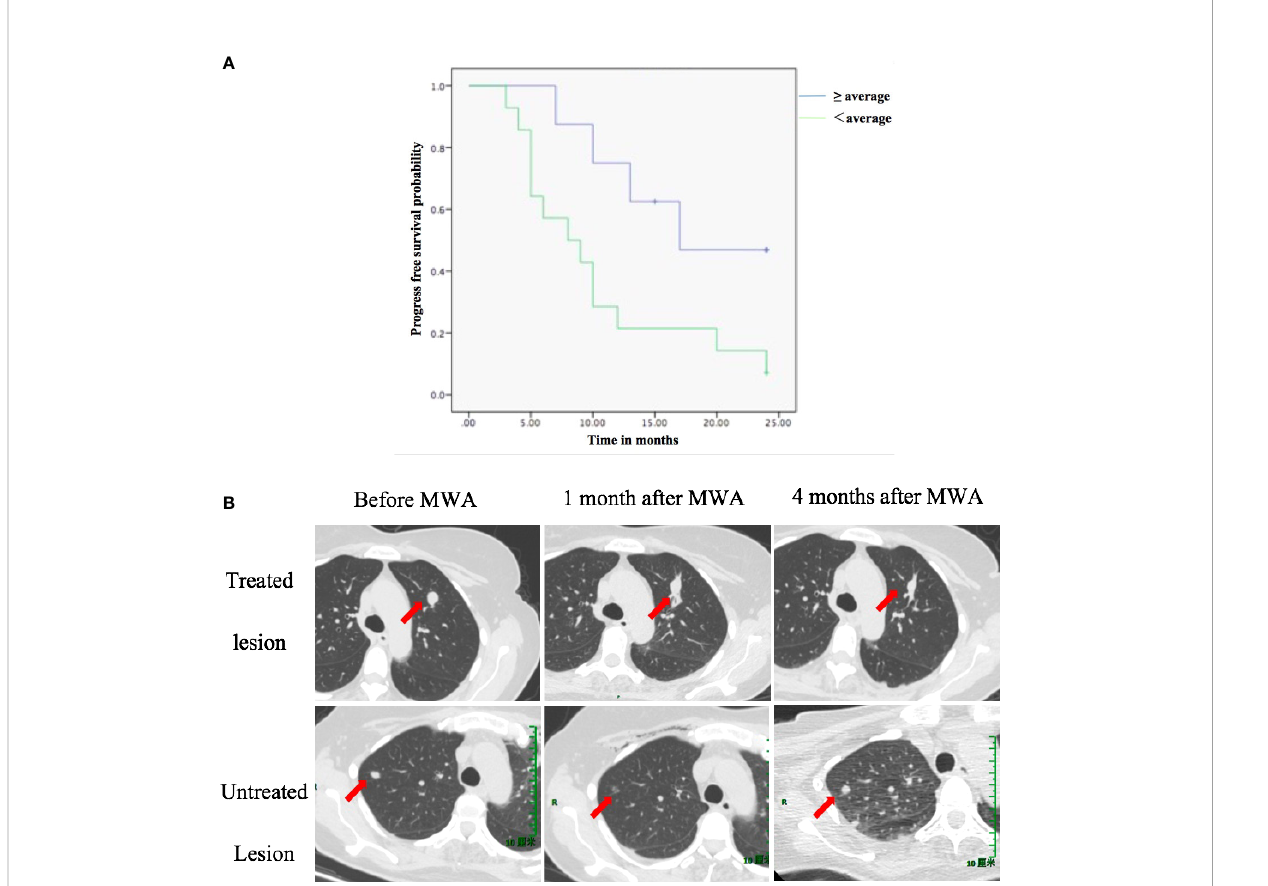
FIGURE 3 The reduction in the proportion of Treg cells is associated with PFS. (A) PFS according to a reduction in the proportion of Treg cells between D0 and M1. (B) A case showing that a reduction in proportion of Treg cells predict PFS. A 49-year-old female was diagnosed with pulmonary oligometastasis of urothelial carcinoma and underwent MWA (upper row: arrow indicated the change of treated lesion at different time point). One month after ablation of the index tumor, an abscopal effect was observed: untreated tumor regression (lower row: arrow indicated the change of untreated lesion at different time point). At M1, the proportion of CD8+ T cells increased from 39% (D0) to 53% (M1). However, the proportion of Treg cells also increased from 8.1% (D0) to 9.7% (M1). Finally, tumor progression was observed 4 months after MWA. The patient ’ s overall survival time was 10 months. D0, day before MWA; M1, one month after MWA; MWA, percutaneous microwave ablation; PFS, progression-free survival; Treg, regulatory T